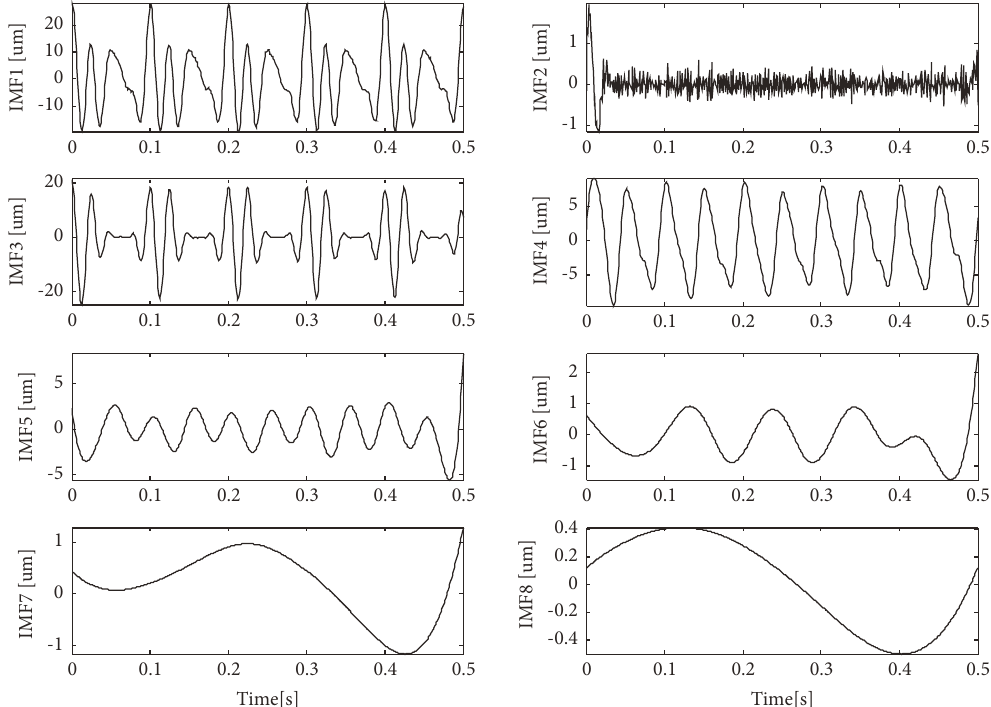
Figure 5: EEMD results of the observed signal in Figure